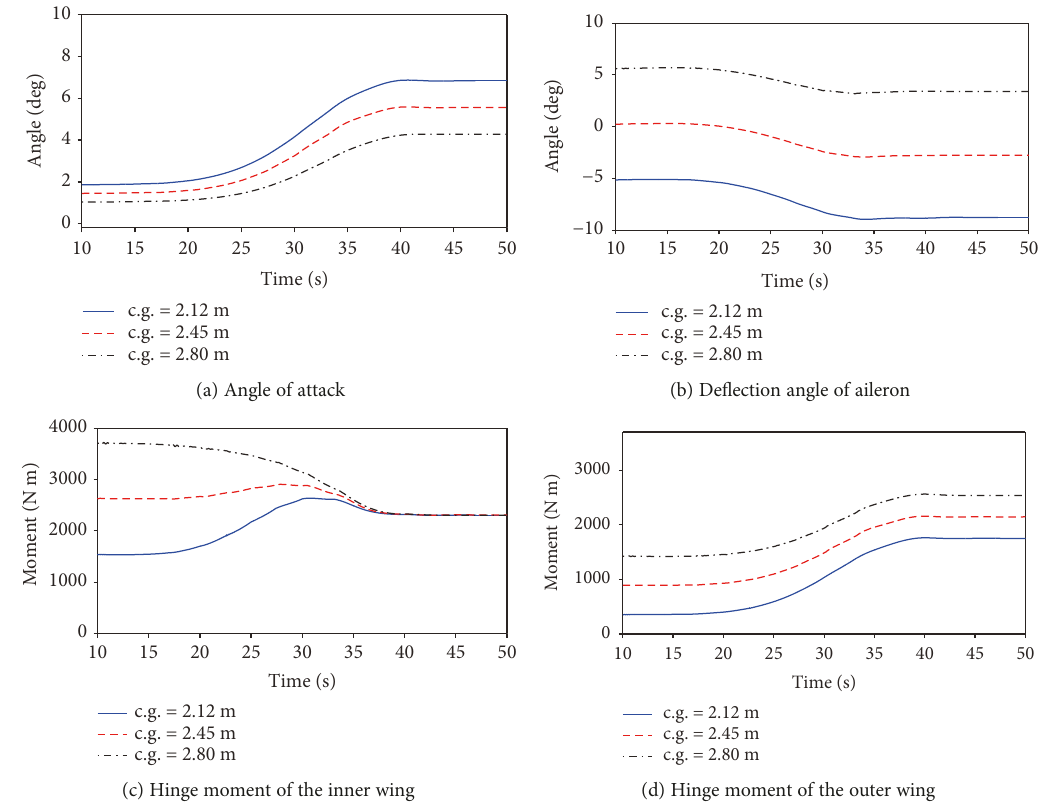
Figure 11: In fl uence of the c.g. position on the response.